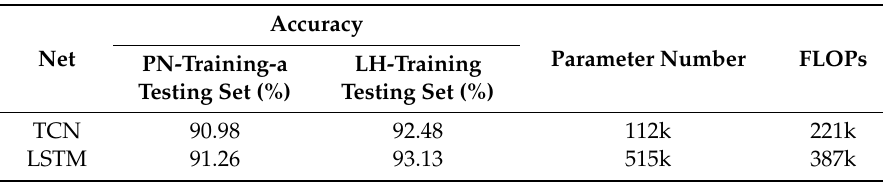
Table 2. Comparison of LSTM and TCN.